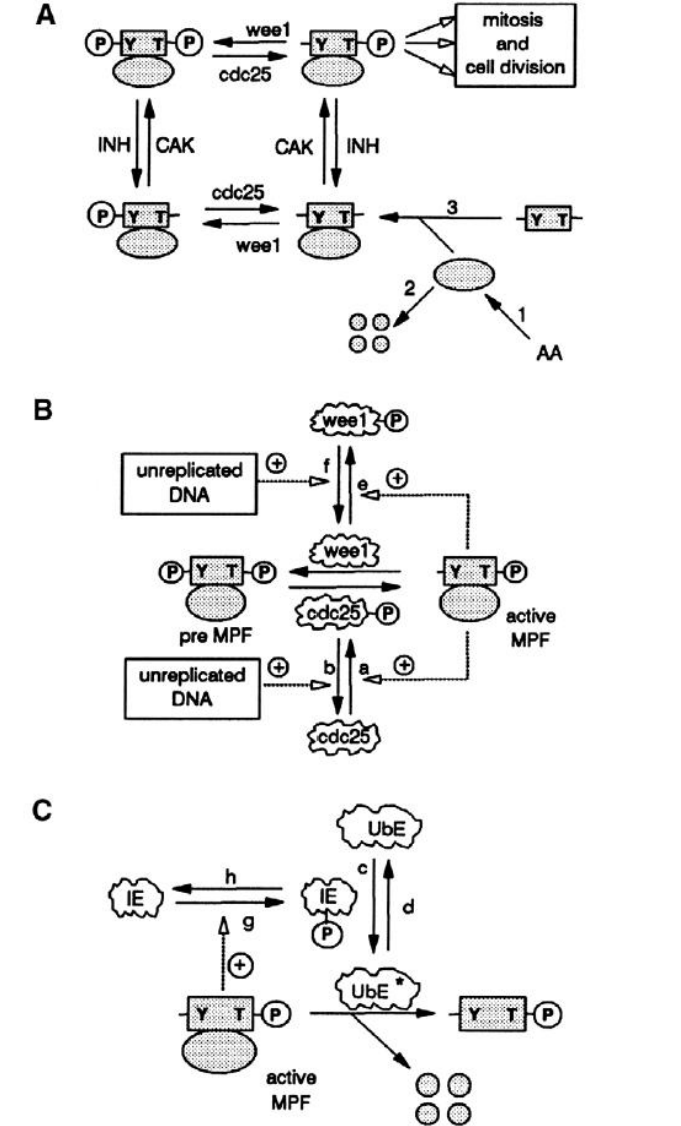
Figure 2. Molecular processes for M-phase control in eukaryotic cells. ( a ) Cdc2 protein kinase monomers combine with cyclin subunits to form dimers. Subunits of kinase Cdc2 can be phosphorylated and desphosphorylated at an activatory threonine (Thr) residue or/and an inhibitory tyrosine (Tyr) residue. All cyclin subunits can be degraded by an ubiquitin pathway. ( b ) Active MPF stimulates its own production, which is positive feedback. ( c ) But active MPF also stimulates the destruction of cyclin, which is negative feedback. Reproduced with permission from the Company of Biologistd Ltd.